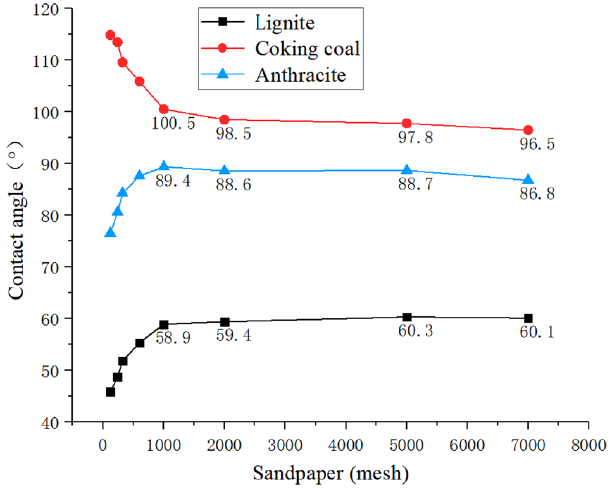
Figure 7. Proximate intrinsic contact angle measurement of the coal samples treated with various sandpapers.